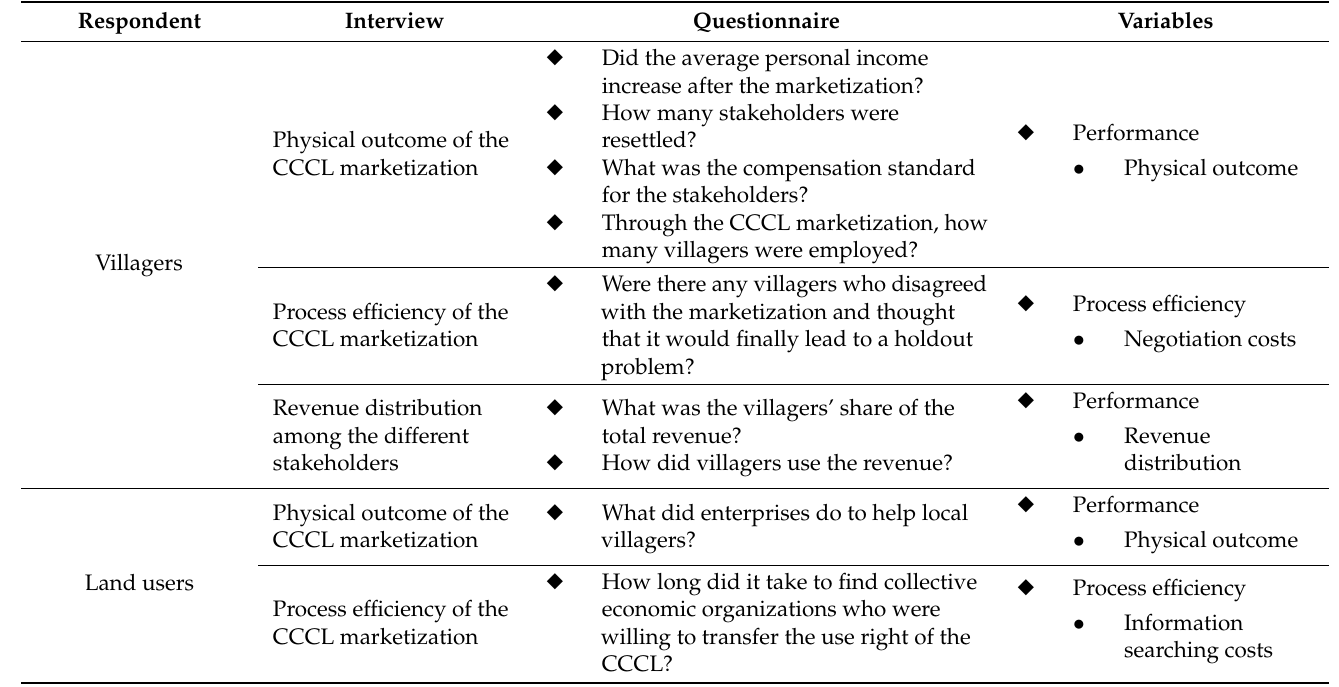
Table 4. The interview, questionnaire, and variables for the villagers and land